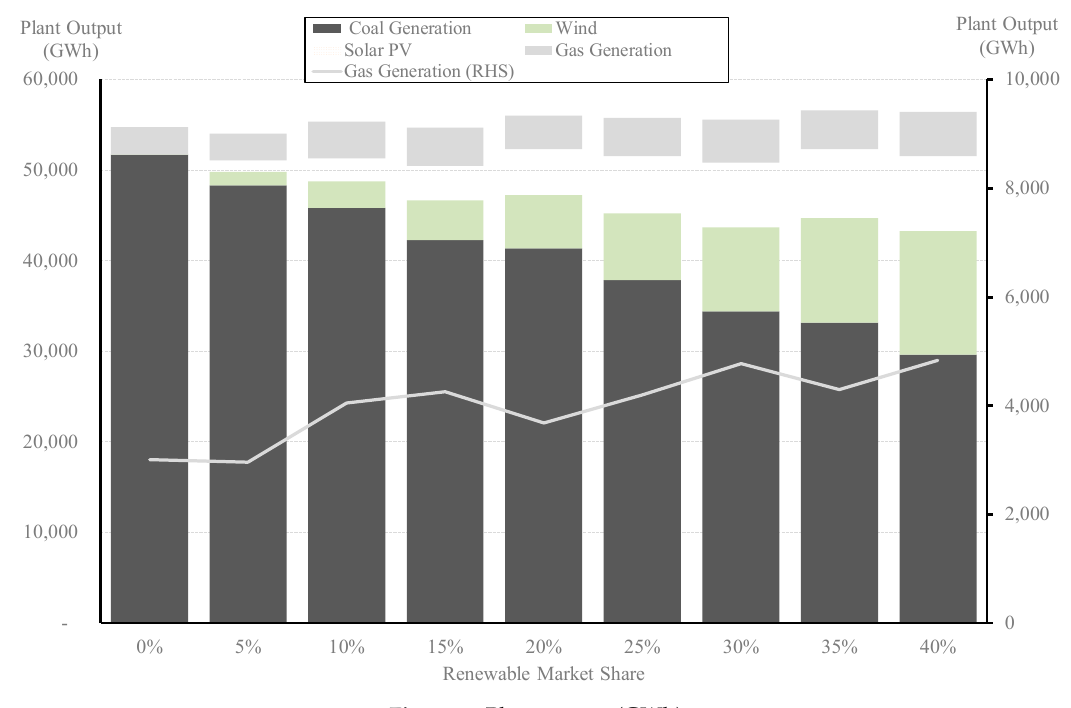
Figure 3. Plant output (GWh).